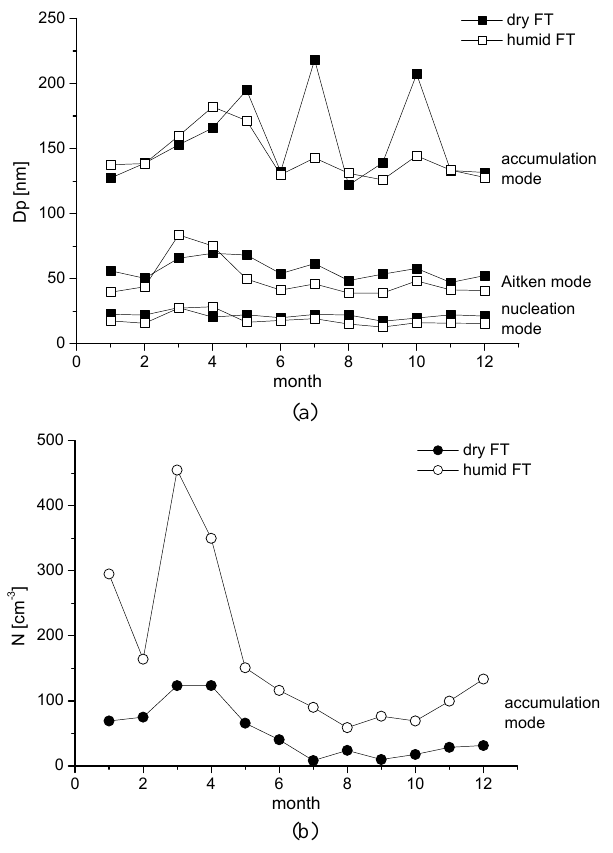
Fig. 4. Annual cycle of (a) the geometric mean diameters of three size distribution modes derived from monthly average distributions (data coverage March 2007–March 2009), (b) the particle number concentrations for the accumulation mode. The number concentra- tions for the Aitken and nucleation modes (cf. Table 4) are not dis- played because they do not show any significant cyclic behaviour.